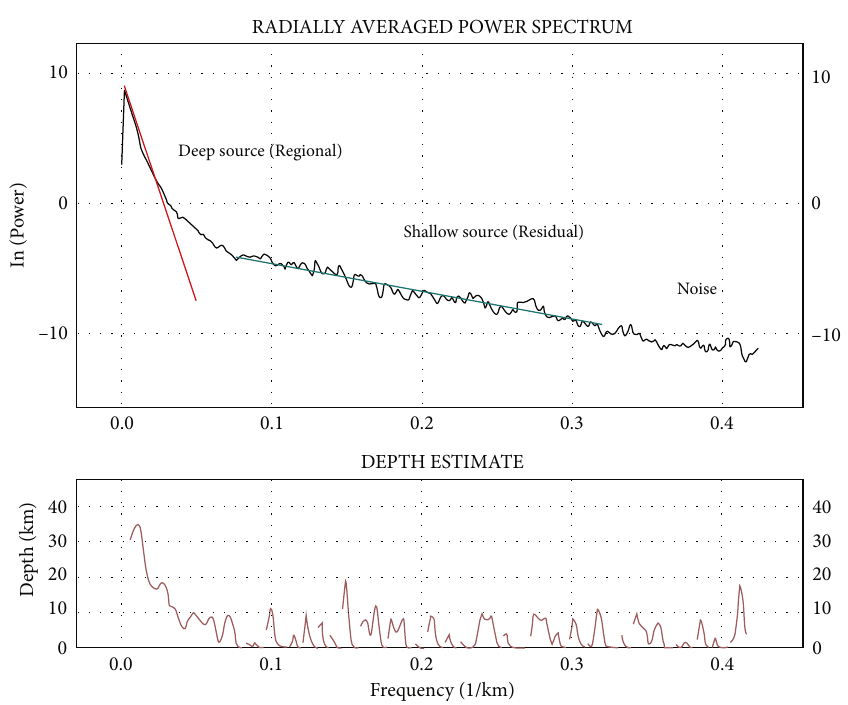
Figure 5: Residual magnetic anomaly map of the study area.